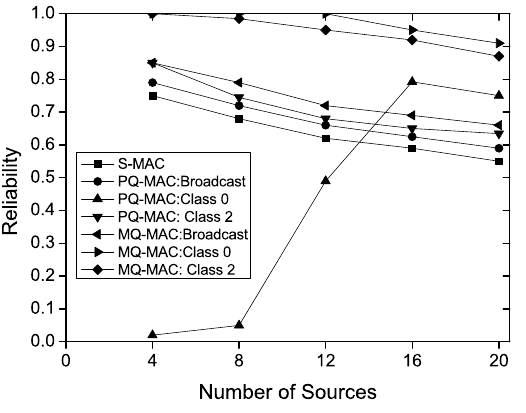
Figure 11. Reliability for different number of sources.